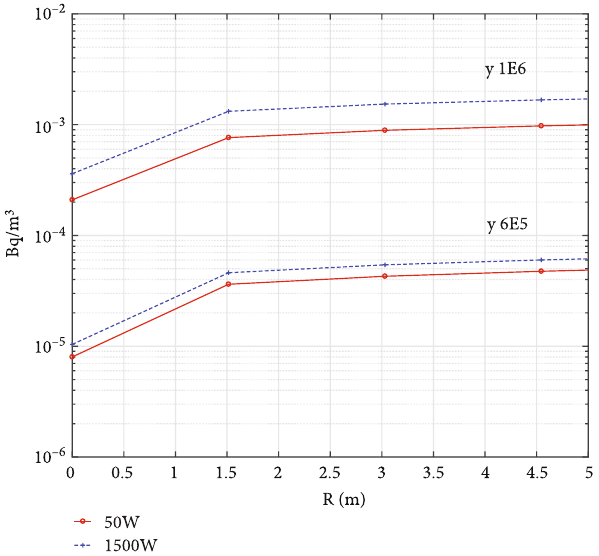
Figure 13: Longitudinal pro fi les of 99 Tc activity concentration and annual dose at the hypothetical well ( Z = − 60 m ) along radial distance R for k = 10 − 16 m 2 , considering 50 Watt (red) and 1500 Watt (blue) heat load for the 500 m deep borehole at 6 × 10 5 and 10 6 years. The jump in the concentration between the back fi ll material and the crystalline rock (at R = 0 m ) is due to much stronger sorption in the rock compared to the